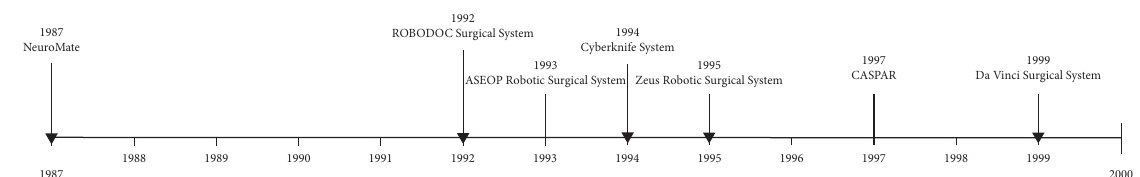
Figure 1: Decade I: timeline of robotic systems that founded and created the base for usage of robots in the medical